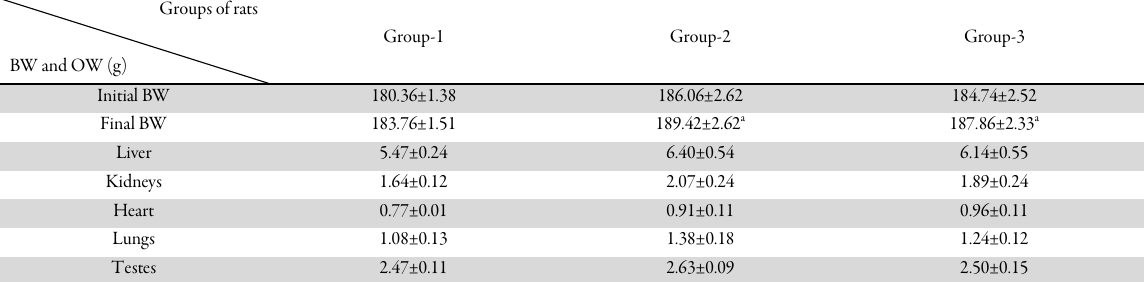
Table 7. Organ weight and body weight of rats treated with vehicle and SNPs 200 and 400 mg/kg. n=5±SE of mean,